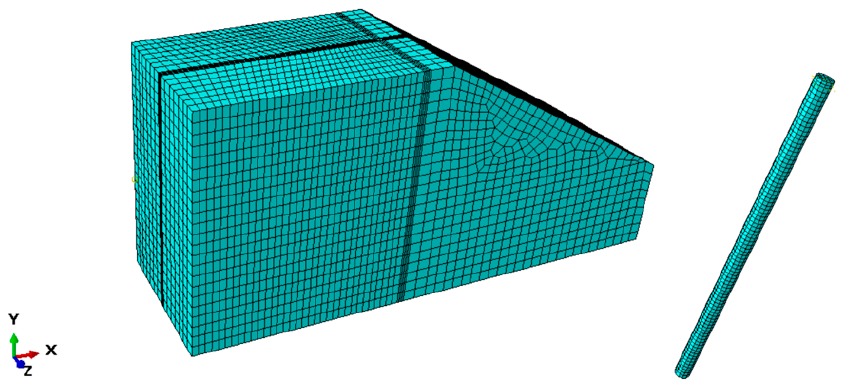
Figure 10. Three-dimensional finite element mesh.